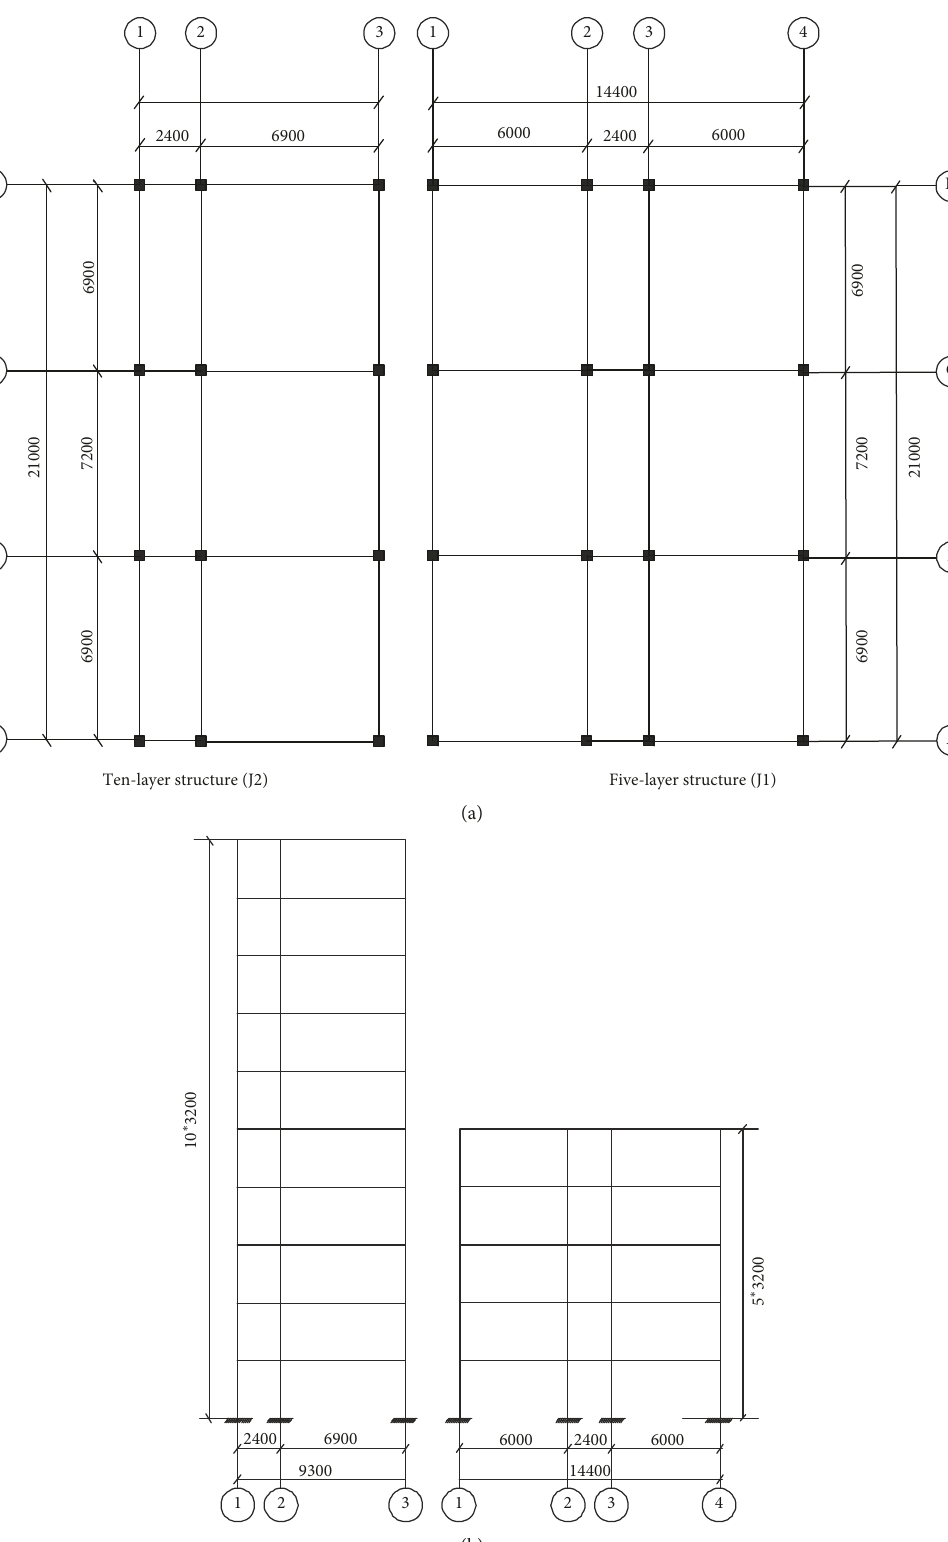
Figure 6: Structure diagram. (a) Structural plan. (b) Structural